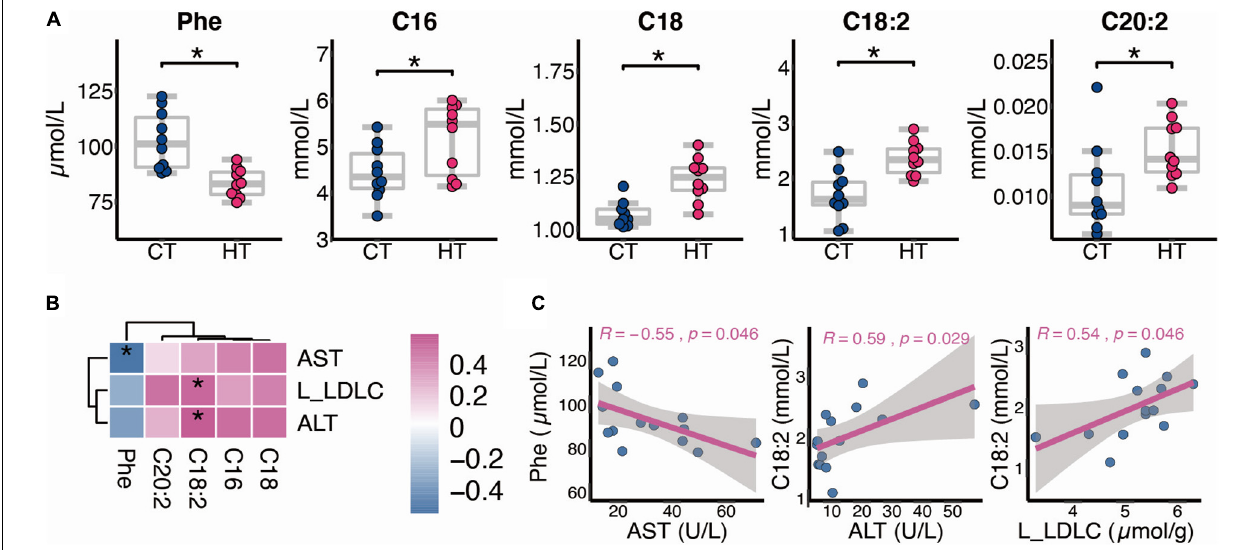
FIGURE 5 | Alternation of serum metabolism between the CT and HT groups. (A) Differential metabolites between the CT and HT groups ( n = 10). (B,C) Spearman correlation between changed metabolites and biochemical indexes ( n = 7, L, liver). The two-tailed Wilcox test was used to determine the significant difference in CT and HT groups. * p < 0.05. CT, control diet and TNBS group; HT, high-fat diet and TNBS group.